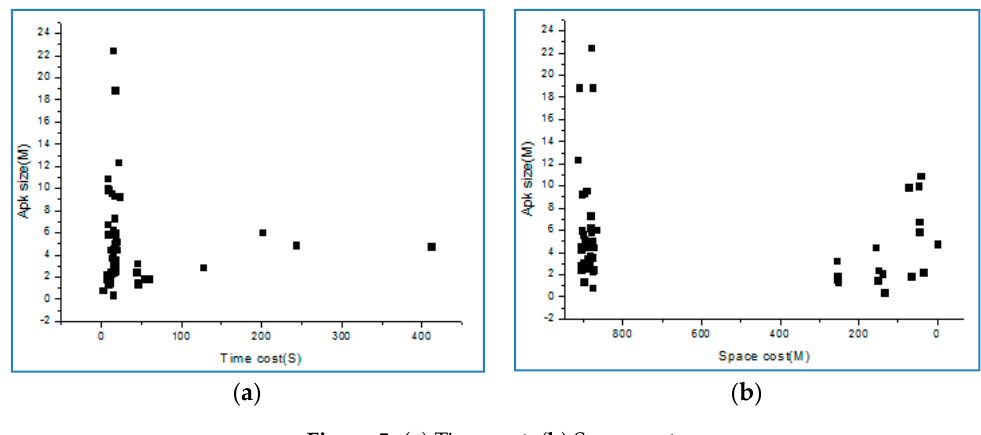
Figure 5. ( a ) Time cost; ( b ) Space cost.